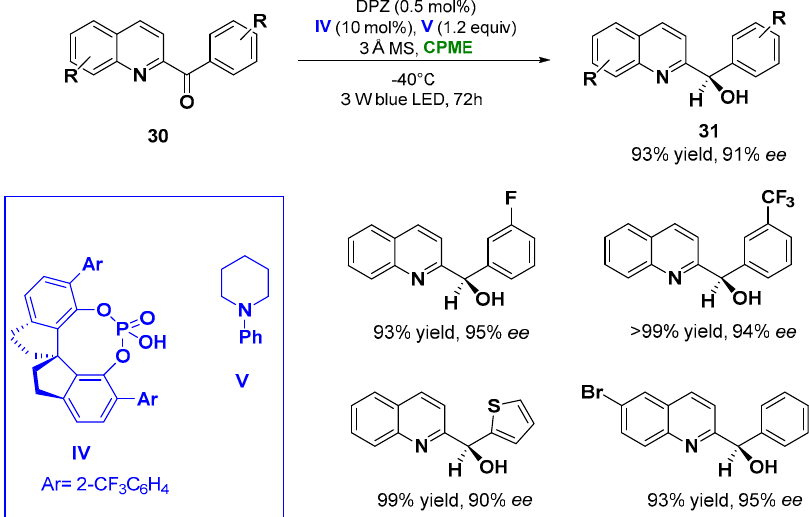
Figure 17. Photocatalytic enantioselective reduction of azaarene-based ketones in CPME employing a chiral phosphoric acid ( IV ) and N -phenylpiperidine ( V ).